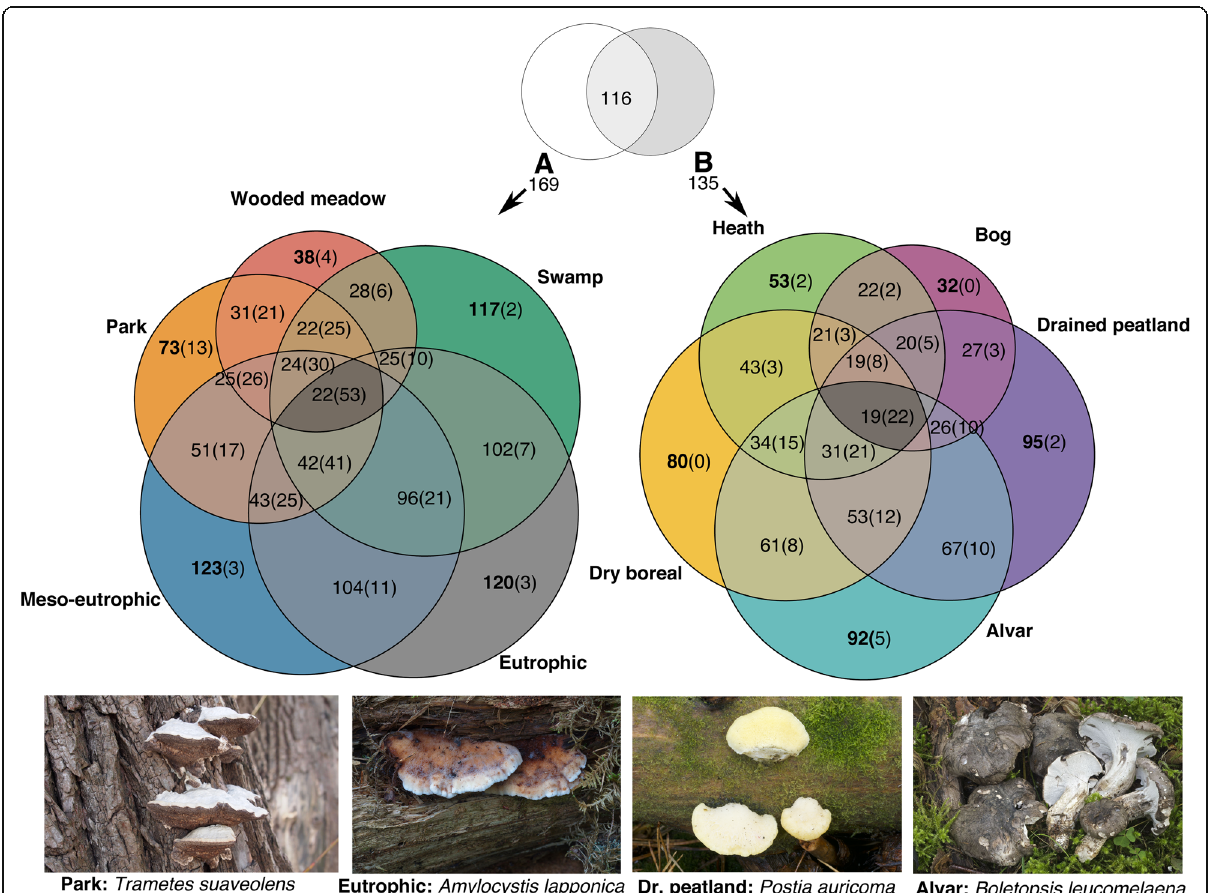
Fig. 3 Euler diagrams of 189 polypore species (including singletons) found in different combinations of Estonian habitat types on fertile soils ( a ) and poor soils ( b ). The numbers before parentheses indicate species found in every habitat type included in the combination; the numbers in parentheses indicate species that have not been found elsewhere (considering both types of soils); examples are illustrated on the photos (Photo credit: V. Liiv, E. Lõhmus, O. Miettinen, U. Ojango). The habitat combinations shown were extracted by the eulerr package (Larsson 2018); see Additional file 7 for statistics of other habitat